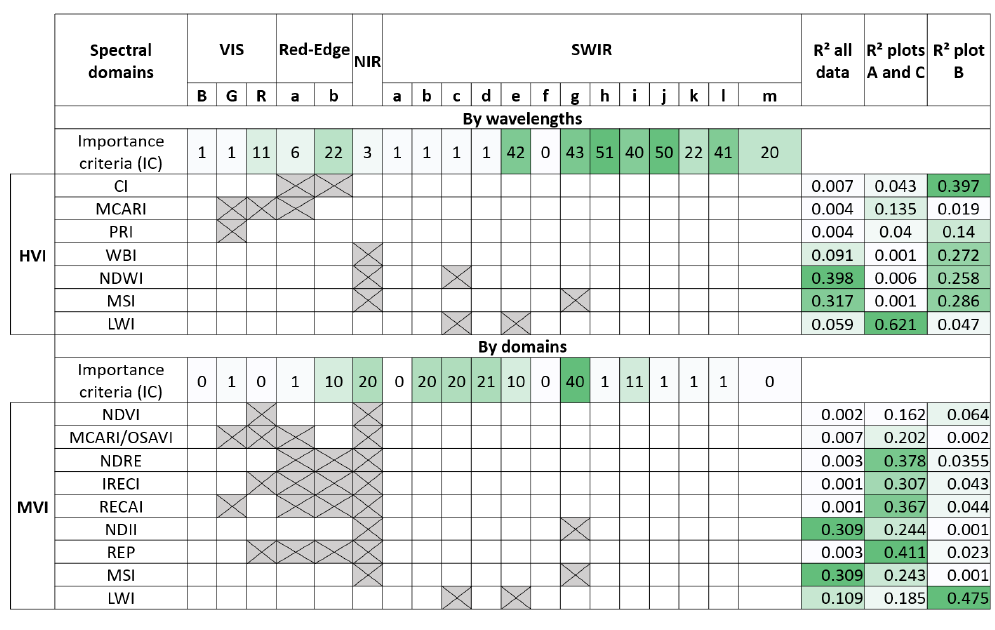
Table 12. Summary of all the previous sections’ results. The importance criteria from Table 10 and Figure 18 are gathered at the top for each feature. The bands that compose the vegetation indices (VI) are checked and shaded out. The determination coefficients obtained between each VI and SWP value are also gathered at the right of the table for all plots or plots A and C and plot B apart. The most important values (IC and R 2 ) are shown in darker